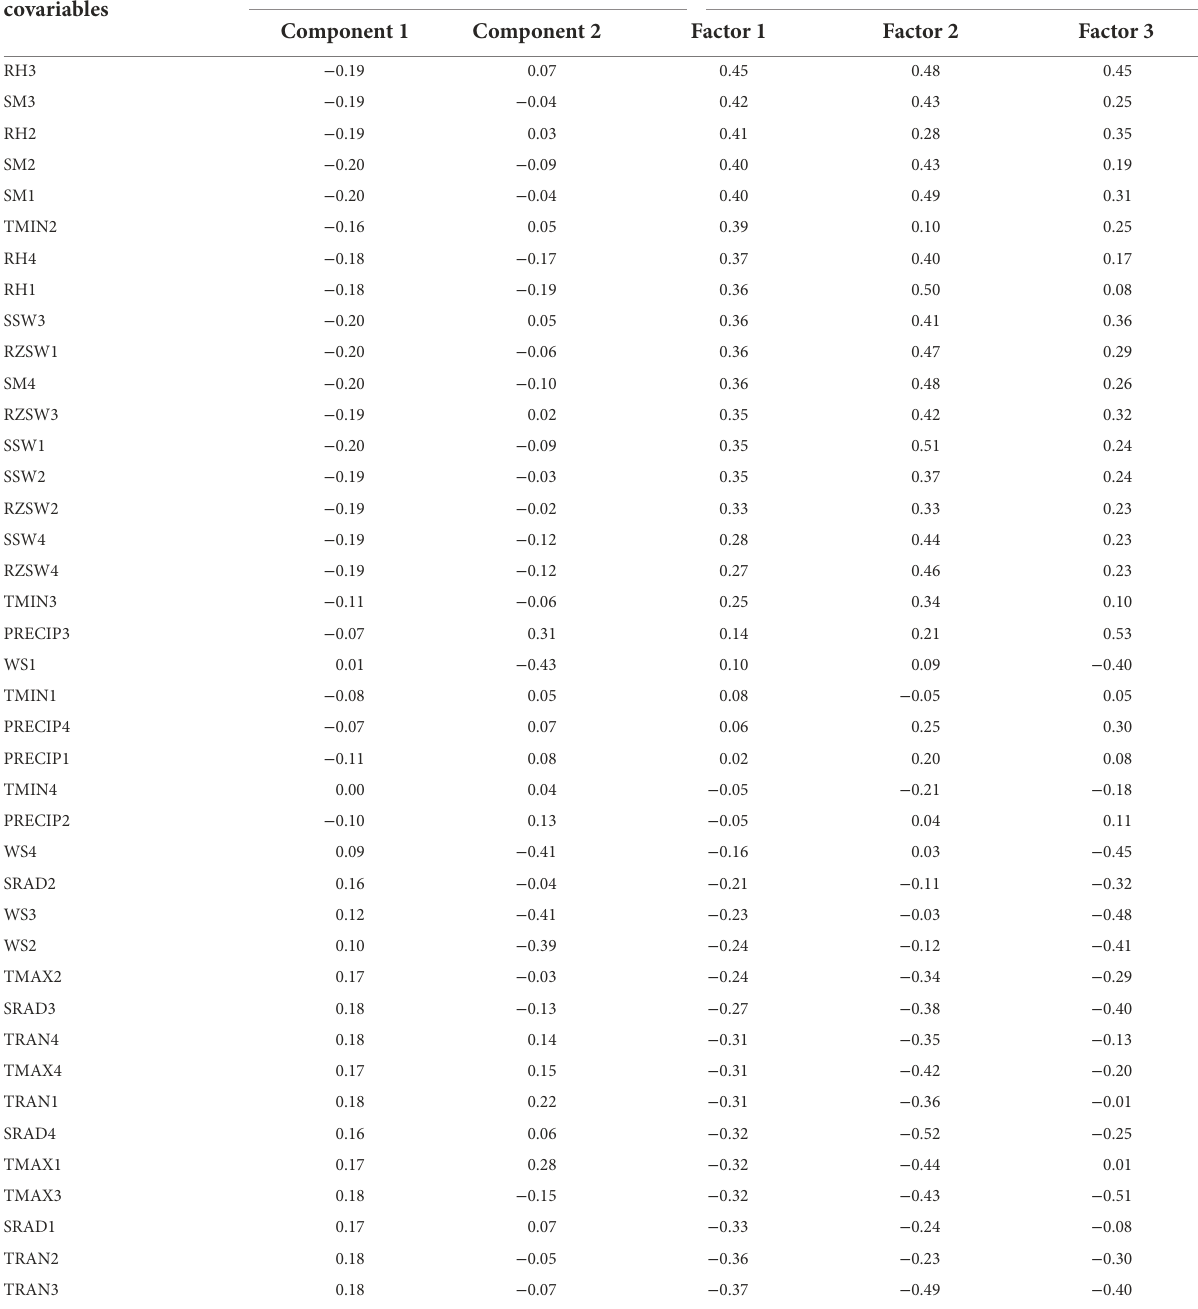
TABLE 5 X-loadings of the first and second PLSR components of environmental covariables and their Pearson’s correlation coefficients sorted in descending order of the first latent factor loadings extracted from the FA3 model. Environmental Partial least squares Factor analytic covariables